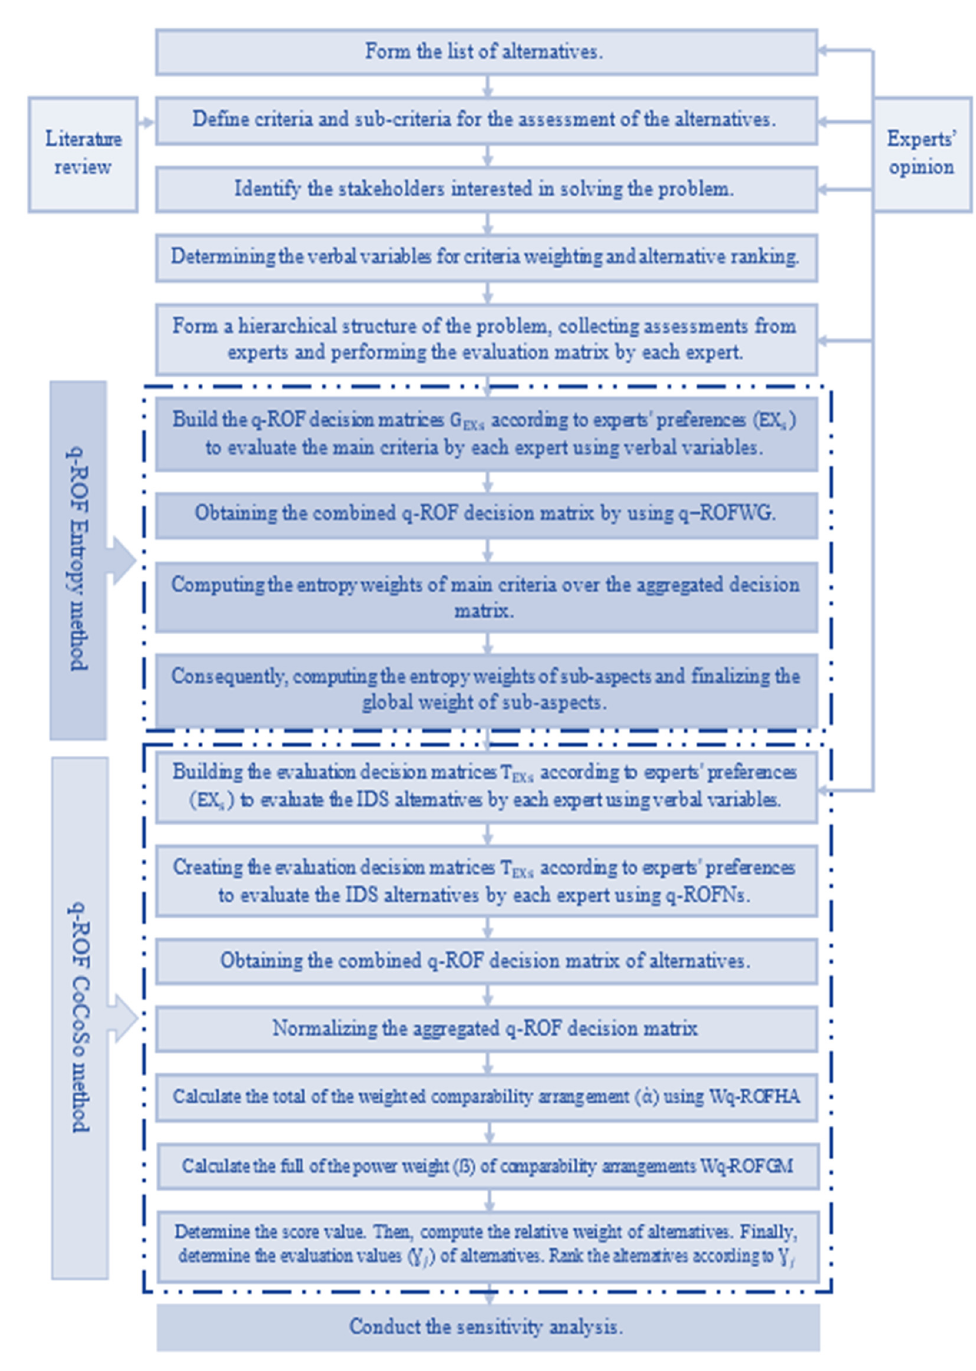
Figure 3. Decision framework for IDS evaluation.